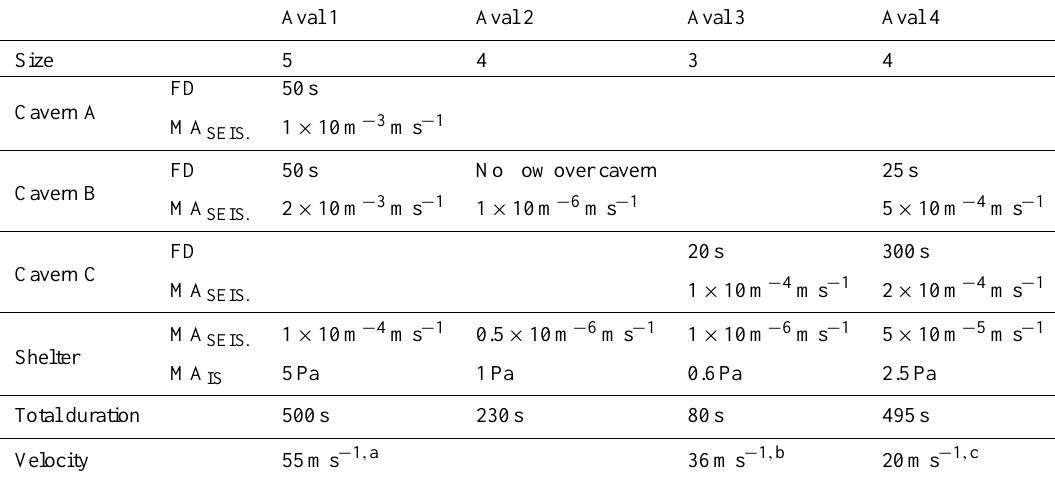
Table 2. Summary of the maximum amplitudes (MA) of the seismic signals (ms − 1 ) and the infrasound signal (Pa). Also summarized is the flow duration (FD) of the avalanches flow over the caverns and the total duration based on seismic and infrasonic